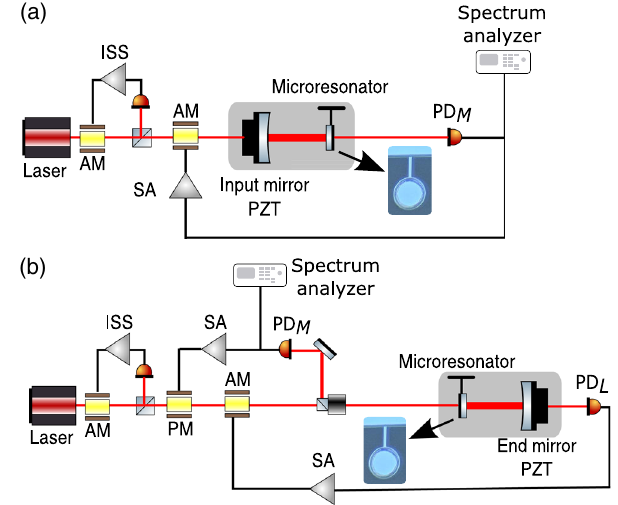
FIG. 2. Experimental setup for the (a) backaction cancellation measurement in transmission of the cavity and (b) benchmark measurement in reflection of the cavity [12]. (a) Light from a 1064 nm Nd ∶ YAG laser is passed through two amplitude modulators (AM) before being injected into the optomechanical cavity, which sits on a suspended optical breadboard to reduce seismic motion and is housed in a vacuum chamber at 10 − 7 Torr (shown in shaded gray). A micrograph of the single-crystal microresonator, comprising a 70 - μ m-diameter GaAs = AlGaAs mirror pad supported by a GaAs cantilever, is included in the diagram. An intensity stabilization servo (ISS) is used to stabilize the laser power to shot noise by feeding back to the first AM. The light transmitted through the optomechanical cavity is detected by photodetector PD M . The signal from PD M is sent through a servo amplifier (SA) before being sent to the second AM to lock the cavity. The signal from PD M is also sent to a spectrum analyzer for further analysis. PZT refers to a